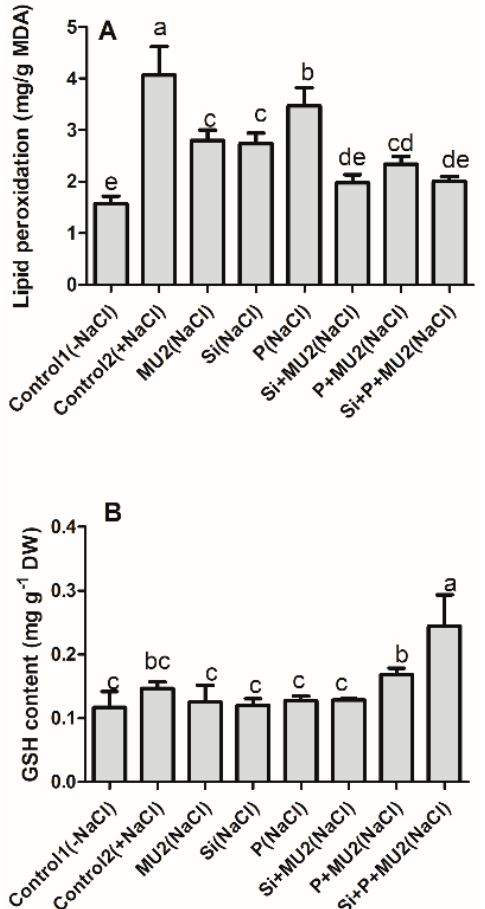
Figure 6. Effect of P. koreensis MU2 inoculation in the antioxidant system of soybean plants under salt-stress conditions: ( A ) Lipid peroxidation; ( B ) Glutathione content. Error bars represent standard deviations. Each data point represents the mean of at least three replications. Bars with different letters are significantly different from each other at p ≤ 0.05. Microorganisms 2020 , 8 , x FOR PEER REVIEW